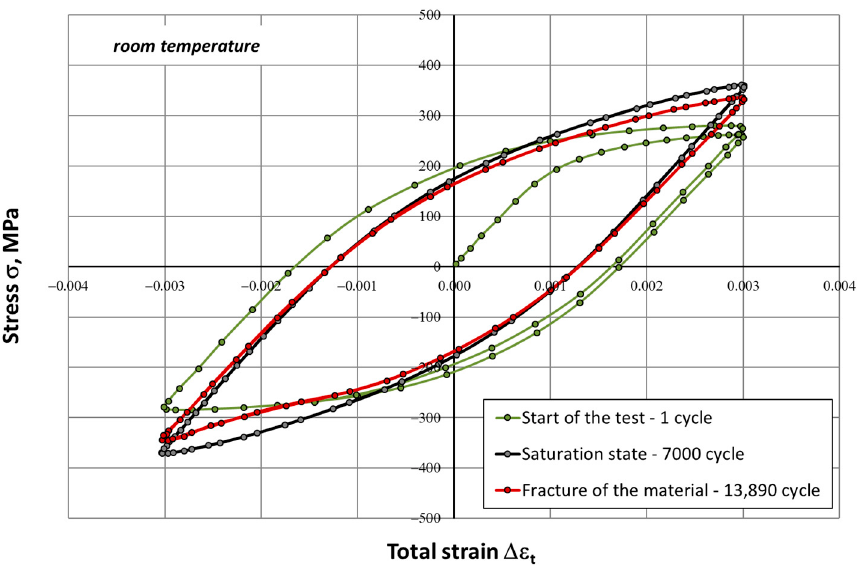
Figure 5. Hysteresis loops determined in a low-cycle fatigue test at room temperature for the strain range ∆ε t = 0.6%.